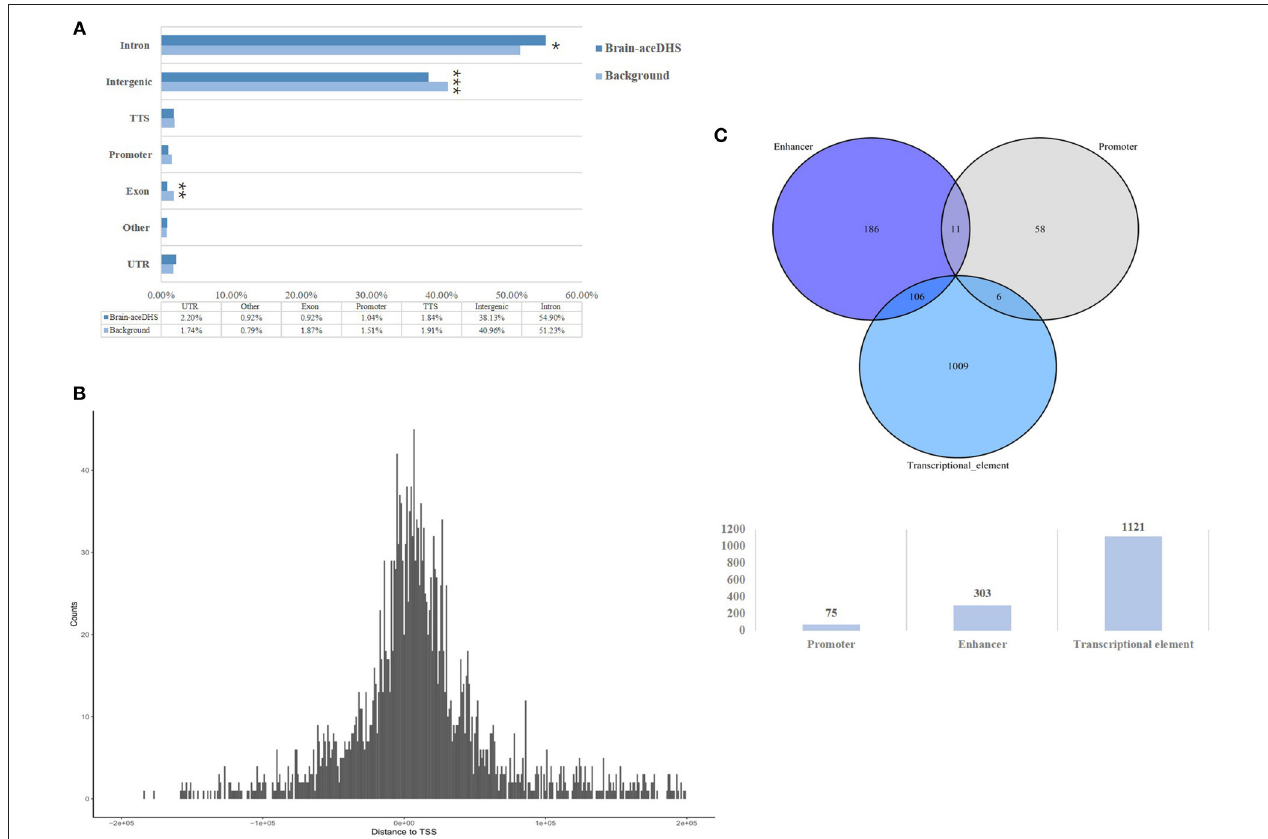
FIGURE 1 | (A) Genomic features of brain-aceDHSs. “Other” indicates undefined non-coding region. Brain-aceDHS vs. background: intron, 54.90 vs. 51.23%, p = 0.05; intergenic, 38.13 vs. 40.96%, p < 2.2e-16; exon, 0.92 vs. 1.87%, p = 0.0008; Pearson’s Chi-squared test. (B) Distance of brain-aceDHSs to TSS. (C) Transcriptional features of brain-aceDHSs, according to embryonic stem cell ChromHMM data. * p < 0.05; ** p < 0.01; *** p <